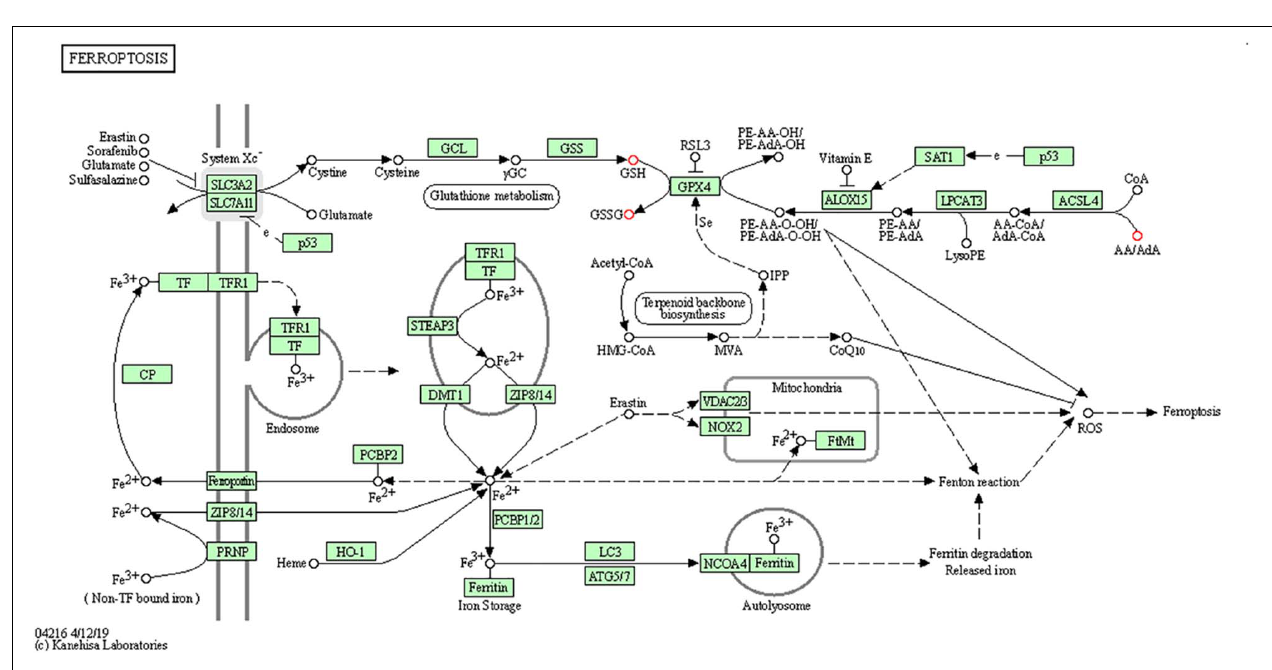
FIGURE 5 | Metabolic pathway analysis. (A) Analyses of KEGG pathway enrichment. The x -axis shows the enrichment factor; the y -axis corresponds to the KEGG pathway. The size of the dot represents the number of metabolites mapped to the reference pathways. The color of the dot represents the p -value. (B) A pathway-based analysis of metabolic changes upon comparing NC with CIH group. The differential abundance score captures the average, gross changes for all metabolites in a pathway. A score of 1 indicates all measured metabolites in the pathway increase, and -1 indicates all measured metabolites in a pathway decrease. The differential color of pathway is mapped into corresponding category of pathway hierarchy.